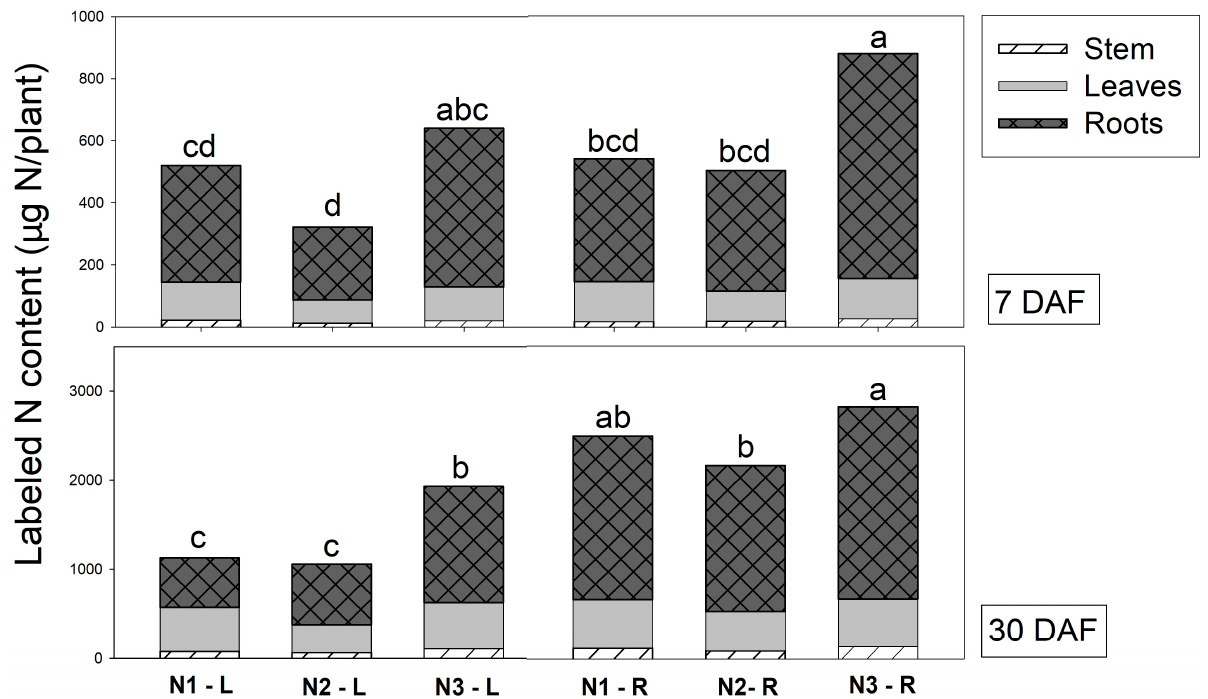
Figure 2. Total N content (µg 15 N/plant) in different organs of Vanda supplied with different labeled N sources ( N1 = 2 . 5 mM 15 NO 3 − + 2 . 5 mM NH 4+ , N2 = 2 . 5 mM NO 3 − + 2 . 5 mM 15 NH 4+ , and N3 = 2 . 5 mM glutamine ) via leaves (L) and roots (R) at 7 and 30 days after feeding (DAF). The different letters denote significant differences in treatments, analyzed by Tukey’s test.